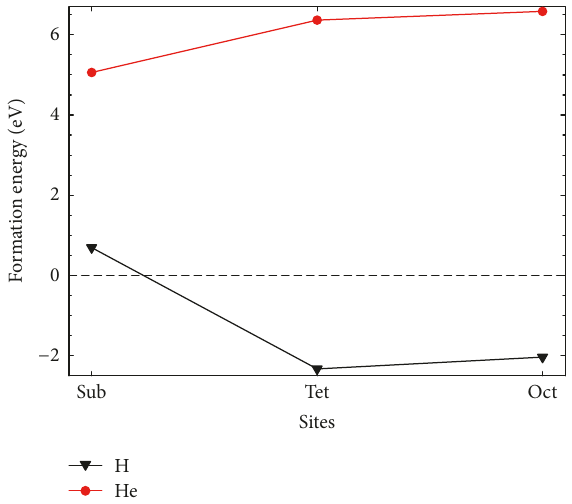
Figure 4: The formation energy of the single defects in